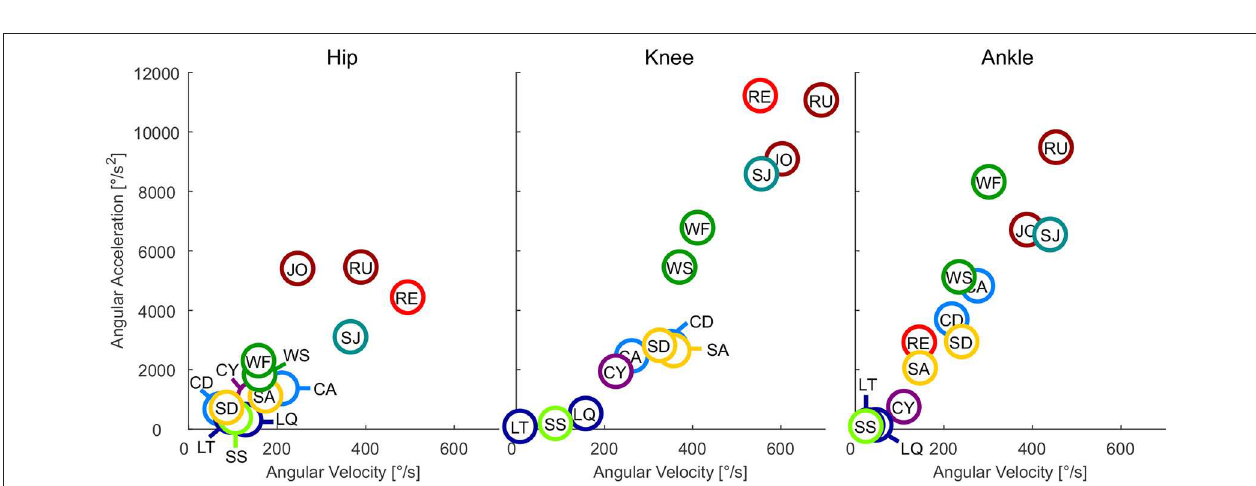
FIGURE 1 | Range of motion of the analyzed movement tasks for the hip, knee, and ankle joint, compared to the mean total range of motion measurements for each joint (TO, gray) determined by Roaas and Andersson (1982). From left to right: walking slow (WS), walking fast (WF), climbing descend (CD), climbing ascend (CA), stair descend (SD), stair ascend (SA), jogging (JO), running (RU), cycling (CY), recovery (RE), squat jump (SJ), squat lifting (LQ), stoop lifting (LT), and sit to stand (SS).